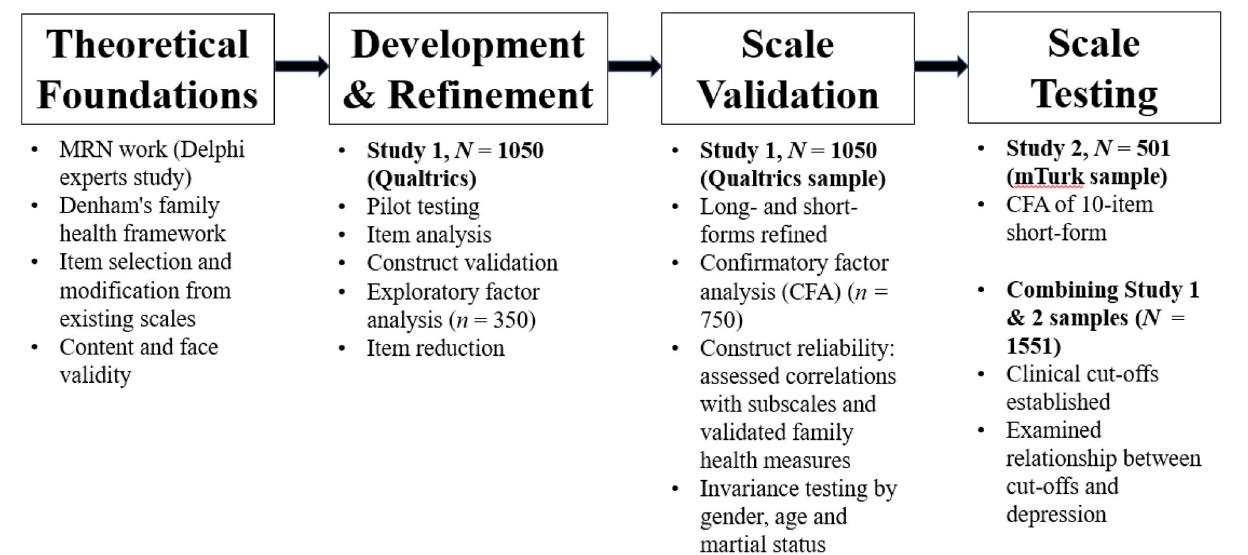
Frontiers in Public Health |